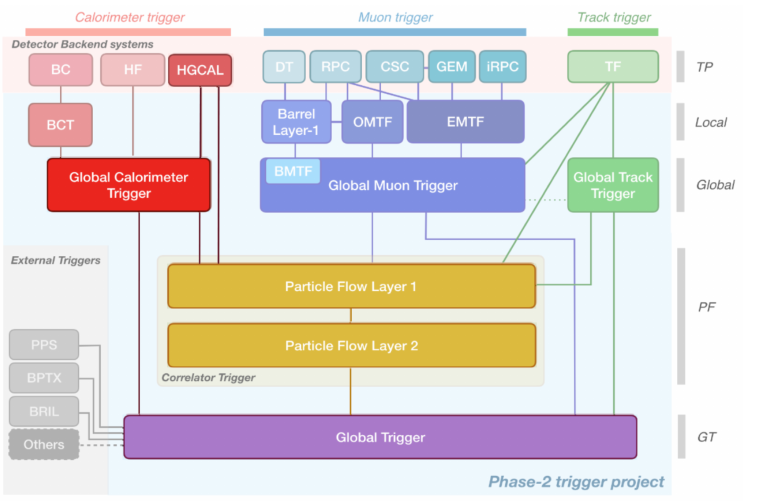
Figure 8. Phase-2 L1 trigger blocks. The blocks receiving HGCAL trigger primitives as input are